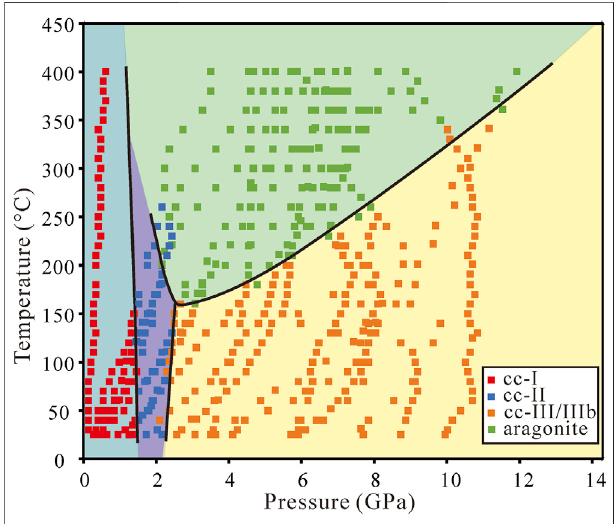
FIGURE 3 | Phase diagram of CaCO 3 in the anhydrous condition. The phase boundary between calcite and aragonite shows a minimum transition temperature at around 150 ° C and 2.4 GPa. Near each segment of the phase boundaries, there are some ambiguous points in which two phases can exist in a small vicinity, especially between cc-II and